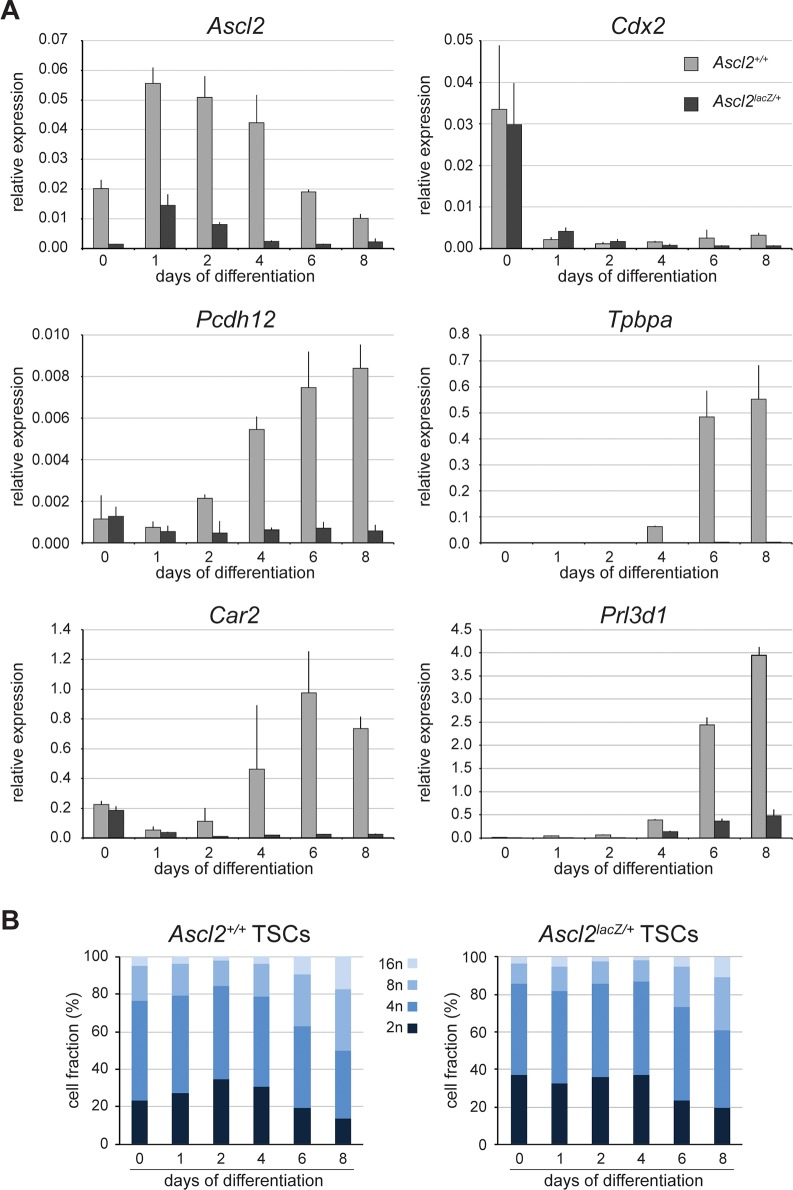
Differentiation defects of Ascl2lacZ/+ trophoblast stem cells.(A) Wild-type (Ascl2+/+) and mutant (Ascl2lacZ/+) TSCs were differentiated by FGF4 and conditioned medium withdrawal for 8 days and RNA samples were collected at the time points shown. Expression levels for Ascl2, Cdx2, Pcdh12, Tpbpa, Car2, and Prl3d1 were analyzed by RT-qPCR and expressed as levels relative to those of the house-keeping gene Ppia. The graphs show the average ± SD for technical triplicates. (B) Flow cytometric analysis of ploidy during TSC differentiation, performed by DNA staining with propidium iodide. Cells of higher ploidy (8n and 16n) are seen in differentiated cells of both genotypes starting at day 6 of differentiation. FACS profiles are shown in S7 Fig.